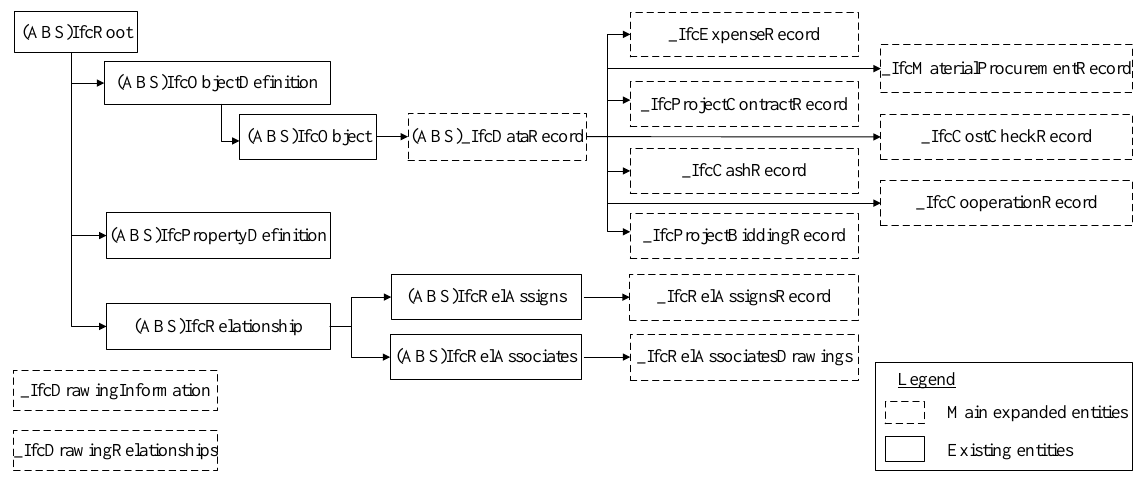
Figure 3 Th e hierarchical structure of existing and expanded IFC entities related to “data records”, “drawings” and “the relationship with drawings” (Ma